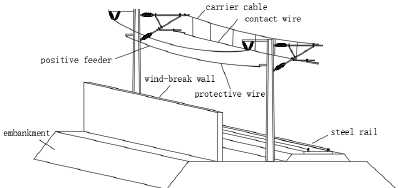
Fig. 1. Schematic diagram of Lanzhou-Urumqi high-speed railway catenary